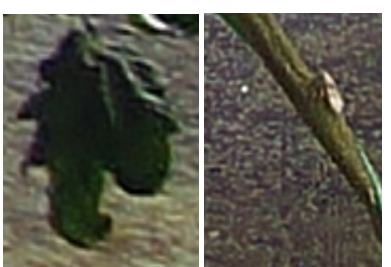
Figure 7. Valid targets.